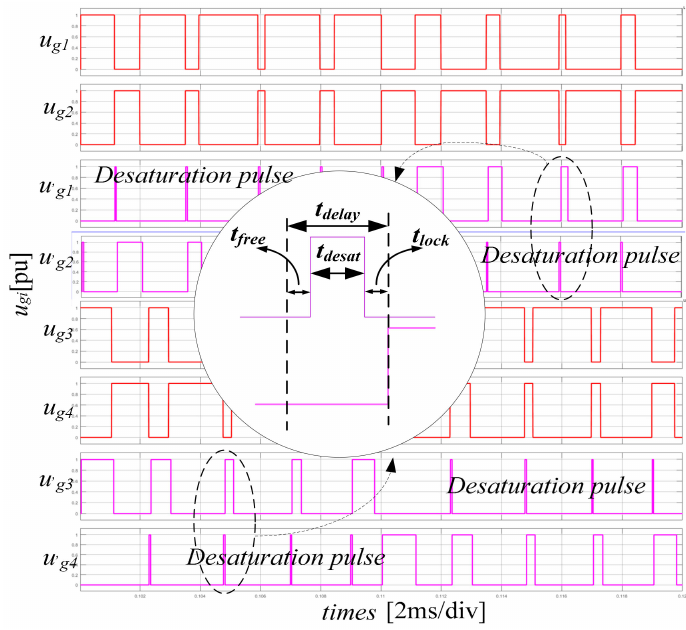
Figure 14. Simulation of the rectify operation for the PWM rectifier with an RC-IGBT. The waveforms of the input voltage V in , output voltage V out , and the inductor current I L are shown in Figure 15. Under rectifier working, the sinusoidal input current is good. The input voltage and current have nearly same phase, and the ripple of the output voltage is less than 4%.